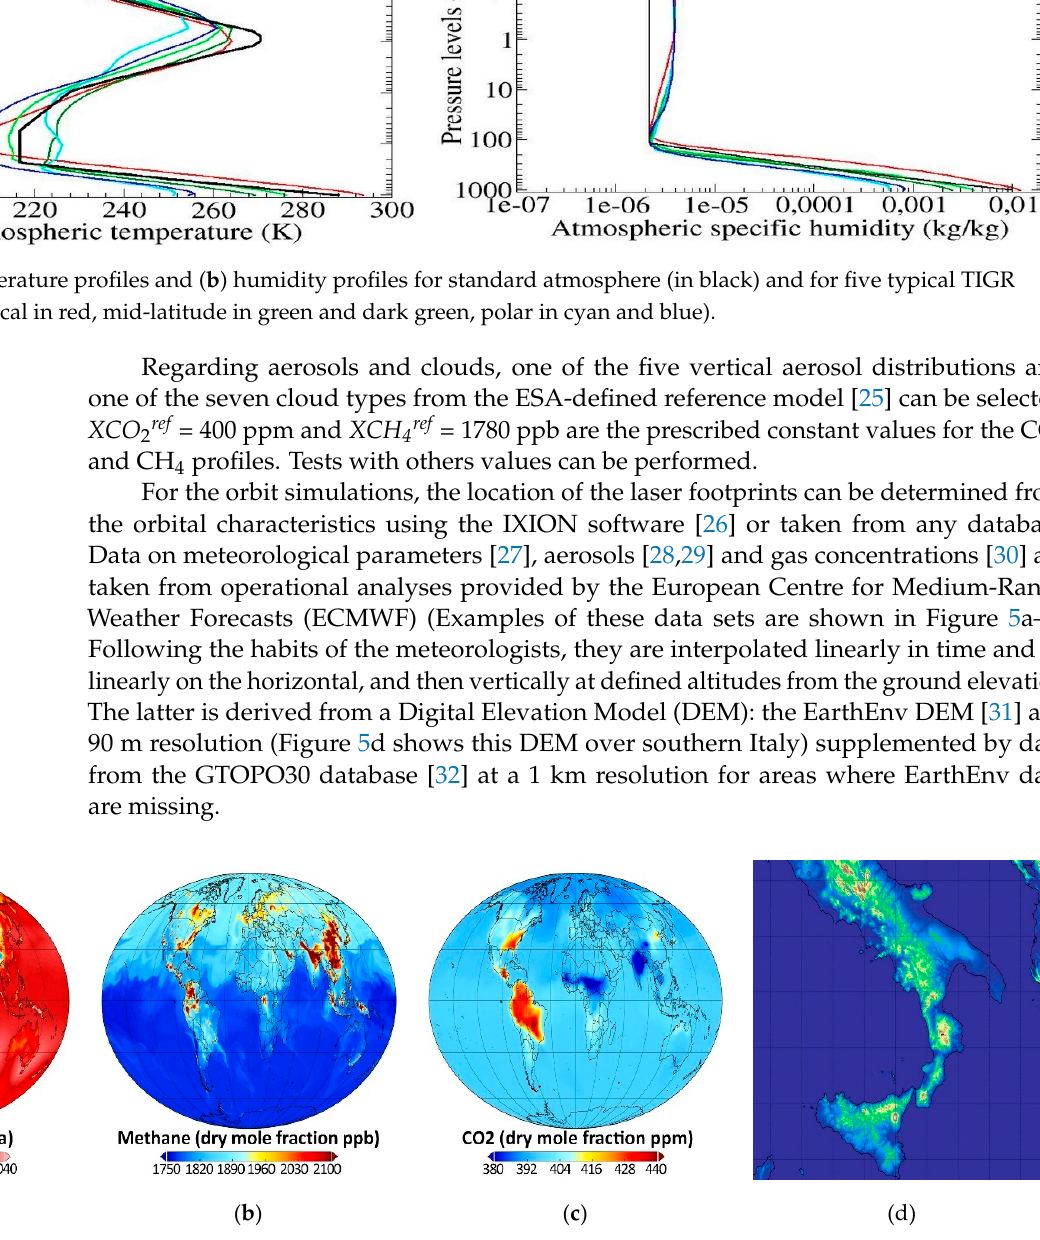
Figure 5. Global maps of: ( a ) surface pressure, ( b ) total methane column, ( c ) total carbon dioxide column from ECMWF available on the 21 September 2014 12H UTC and ( d ) EarthEnv DEM over southern Italy.